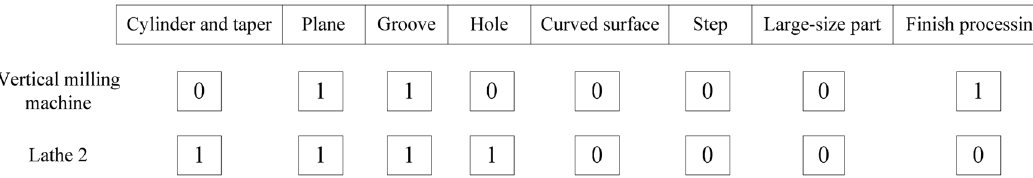
Figure 3. Vector representation of manufacturing